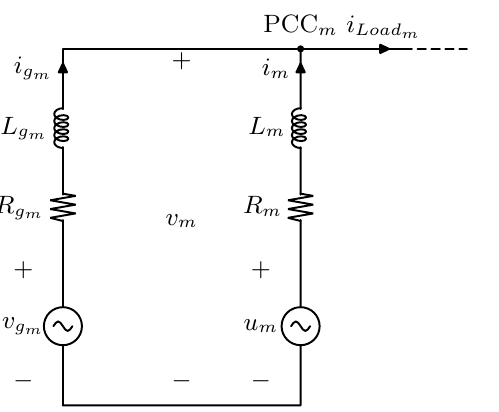
Figure 2. Three-level three-phase neutral-point clamped (NPC) converter.